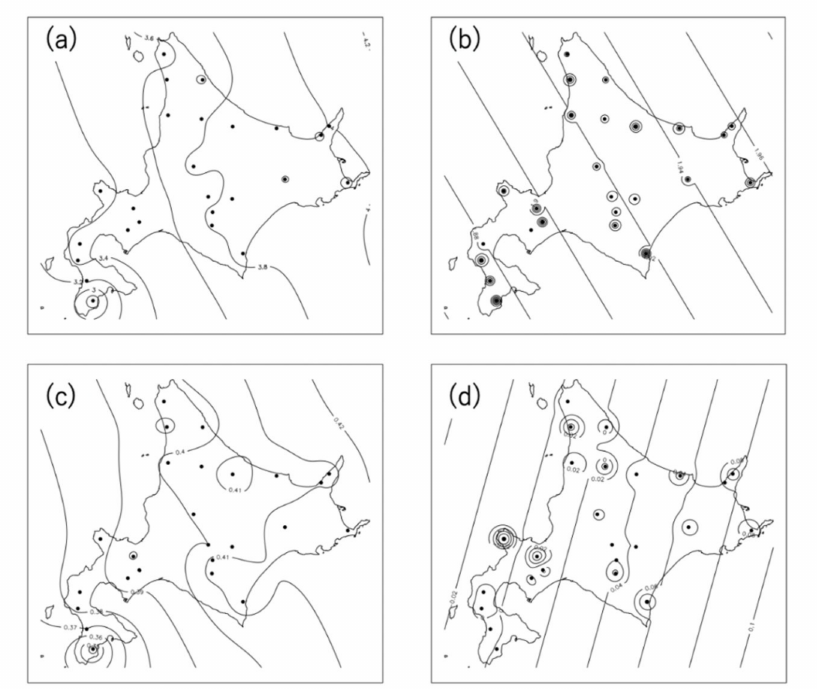
Figure 2. Spatial contour maps of four genetic parameters, the number of alleles ( a ), e ff ective number of alleles ( b ), H E ( c ), and G IS ( d ), measured for the 25 natural populations. Dots indicate study sites (cf., Table 1, Figure 1).